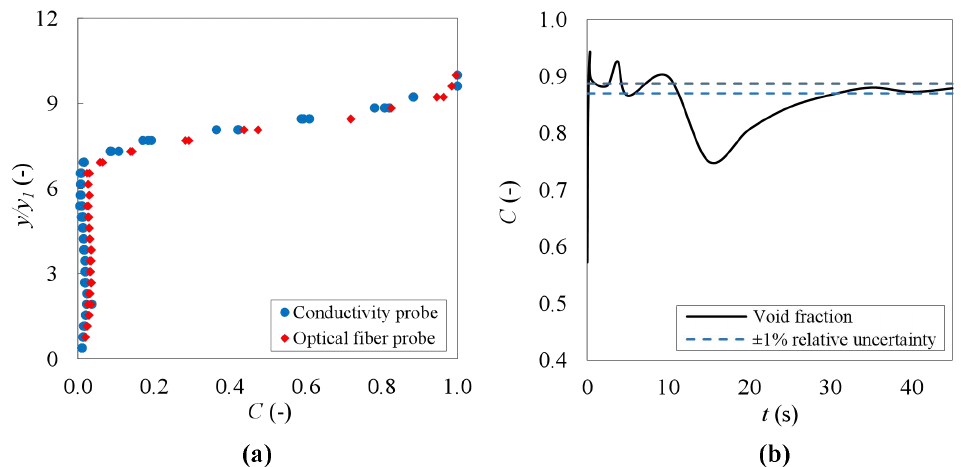
Figure 3. Analysis of the conductivity probe: ( a ) comparison with an optical fiber probe in the center of the roller of a hydraulic jump with F r = 7.6 (adapted from Ortega et al. [21]); ( b ) evolution of the void fraction during a sampling test.